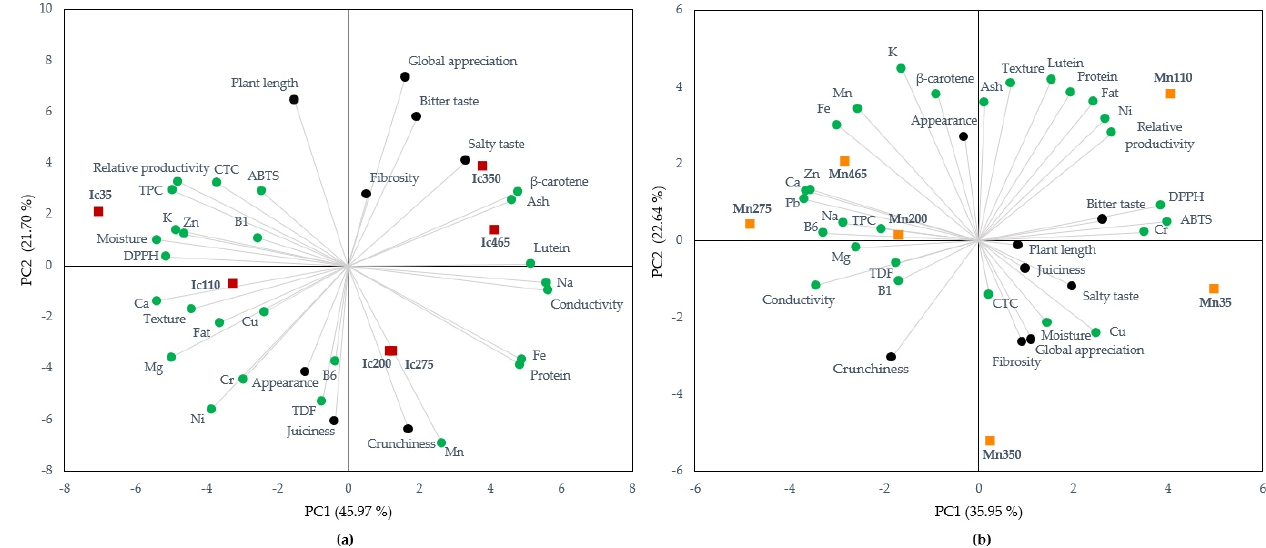
Figure 4. Principal components analysis biplot showing the loadings on PC1 and PC2 of the different parameters of the nutritional profile (green circles), organoleptic characteristics ranking (black circles), and data scores of I. crithmoides ( a ) and M. nodiflorum ( b ) grown under different salinities (red and orange squares).